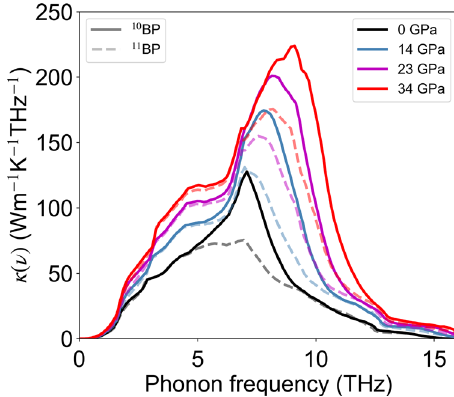
Fig. 5 Spectral contributions to the thermal conductivity of BP. Spectral contributions, κ ( ν ), to the thermal conductivity, κ , of 10 BP and 11 BP as a function of phonon frequency, ν , at different values of P at RT. The sharply peaked contributions to κ result from the upward shift in frequency of AAO processes that increasingly expose the dip in the AAA scattering